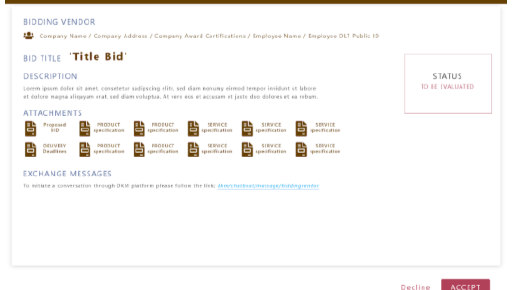
Figure A6. Summary view of a